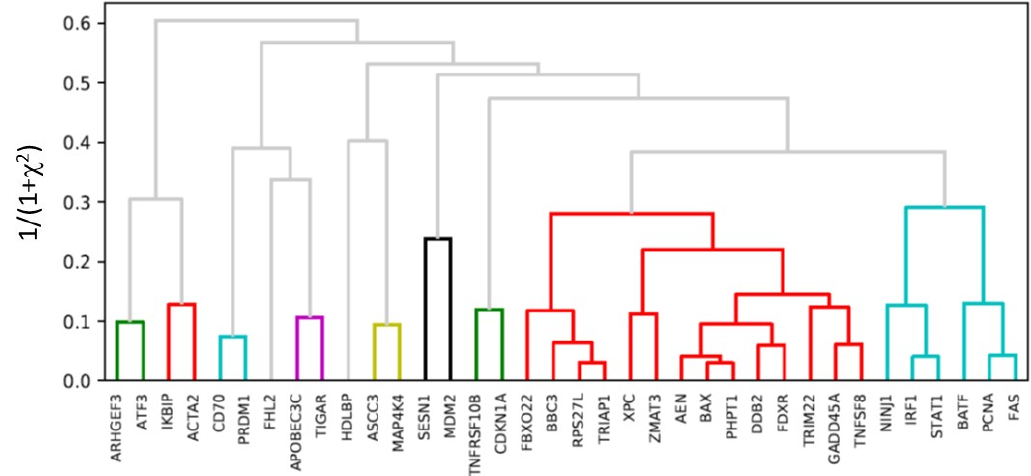
Figure 5. Hierarchical clustering of the radiation response genes from the expression in all of the individual cells that were irradiated. Genes that are involved in TP53 signaling pathways ( AEN, PHPT1 and etc.) and STAT1 signaling pathways ( IRF1, FAS, BATF, NINJ1, and FCNA ) are grouped together, indicating that these were the two primary pathways in response to radiation exposure in T cells.